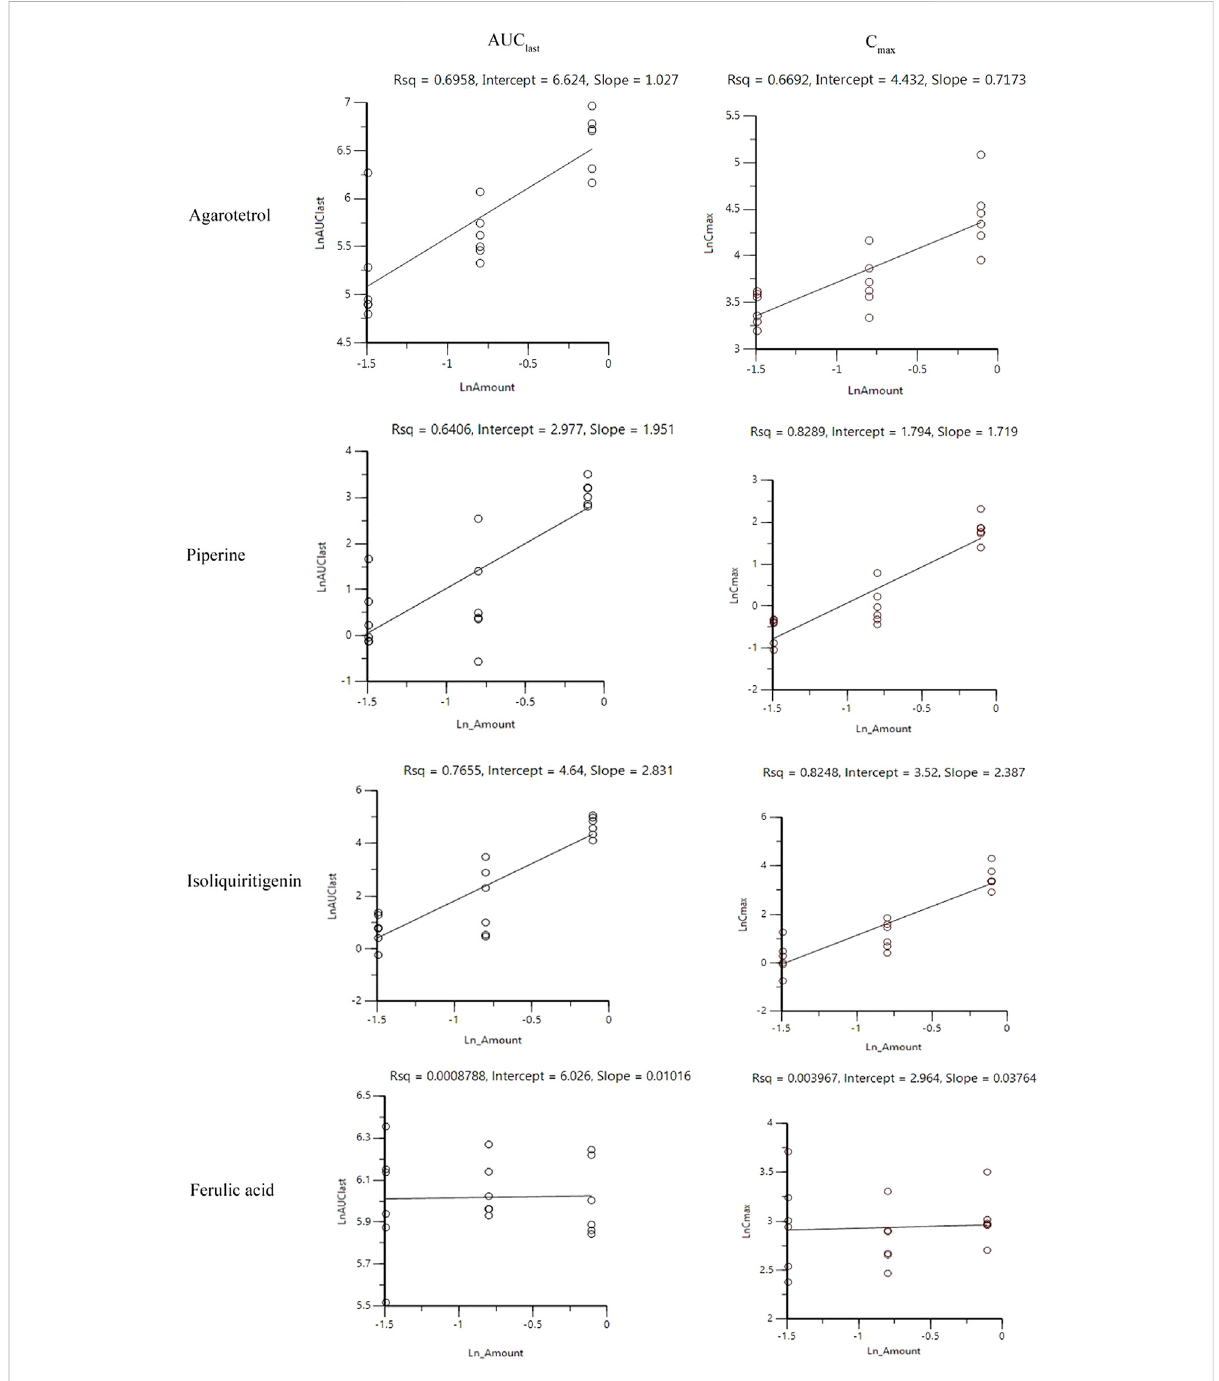
FIGURE 2 Linear relationship between the logarithmic dose of AUC 0-t and C max